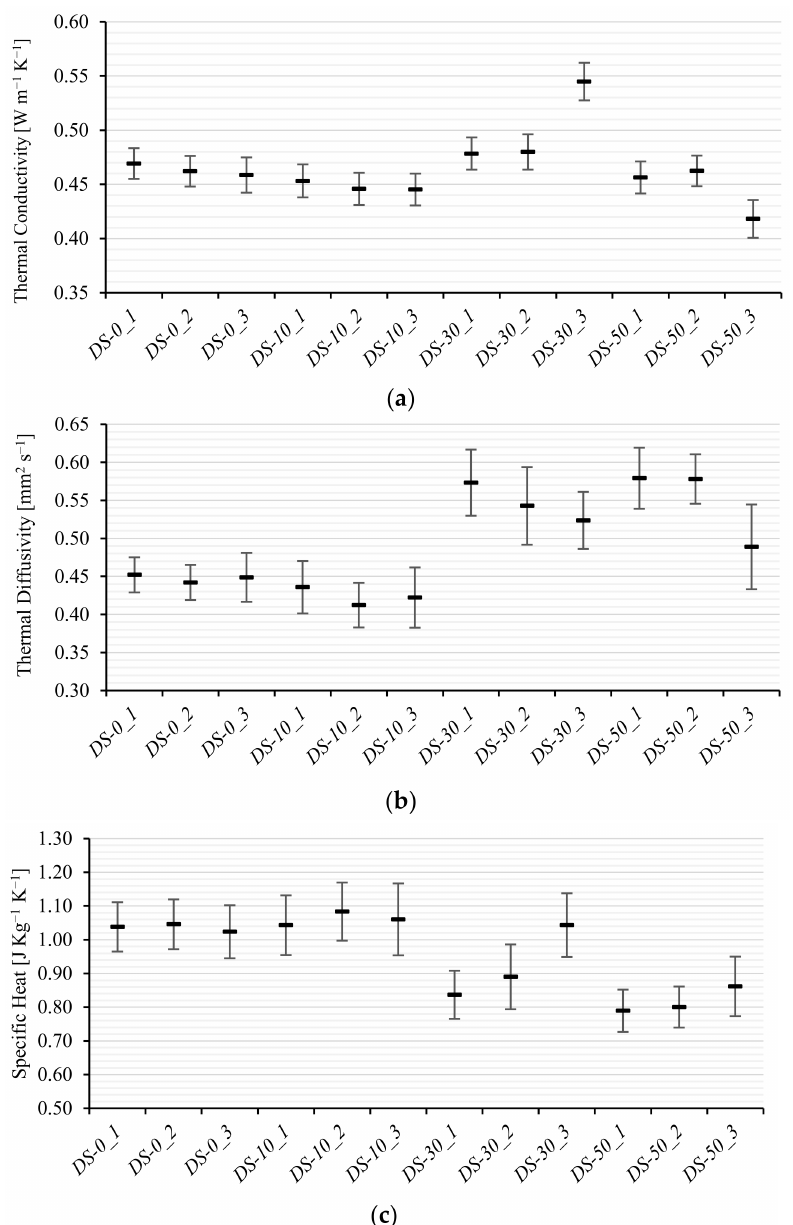
Figure 5. Thermal conductivity ( a ), thermal diffusivity ( b ), and specific heat ( c ) estimated for brick specimens (three samples for each brick specimen) through the hot disk apparatus. Outcomes from the color assessments are reported in Table 7. Adding DS to the NC mixture barely caused a variation in the color pattern of the bricks. The color shifting from the reference case (DS-0) was estimated as high as 1.12, 3.09, and 5.88 for DS-10, DS-30, and DS-50, respectively. To better understand the magnitude of these color changes, it must be reported that a ∆ C value lower than 1.50 is generally considered by most of the industries as the criterion for color approval when testing different samples of the